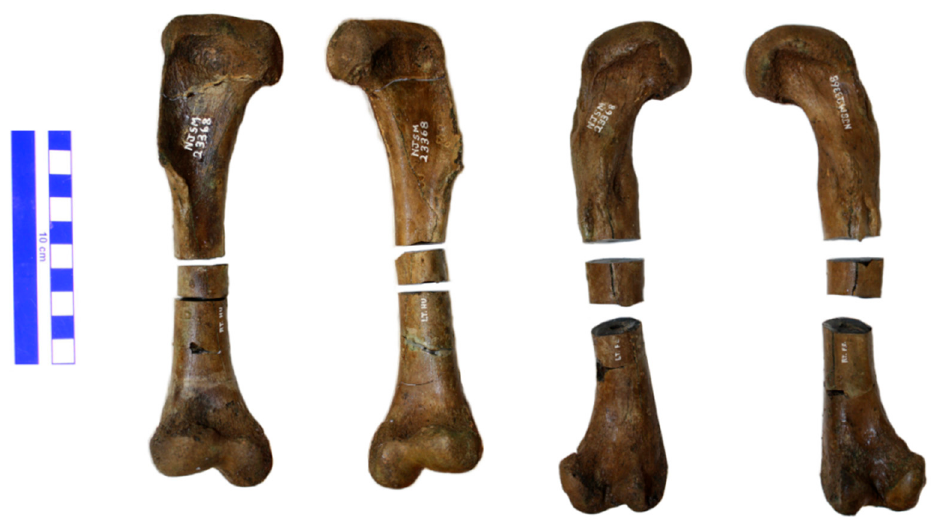
Figure 2. Left to right: NJSM 23368 right humerus, left humerus, left femur, and right femur with extracted samples for thin-sectioning generally in place. The humeri are in anterior view and the femora in posterior view. The large scale bar is 10 cm. This is a composite image.